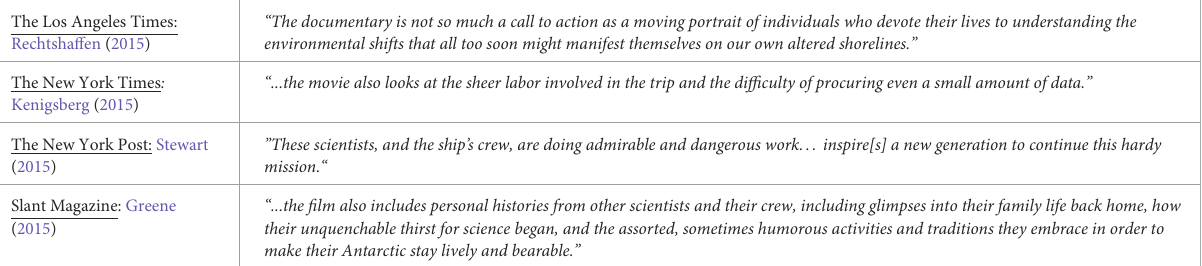
TABLE 1 Published Antarctic Edge: 70 ◦ South film